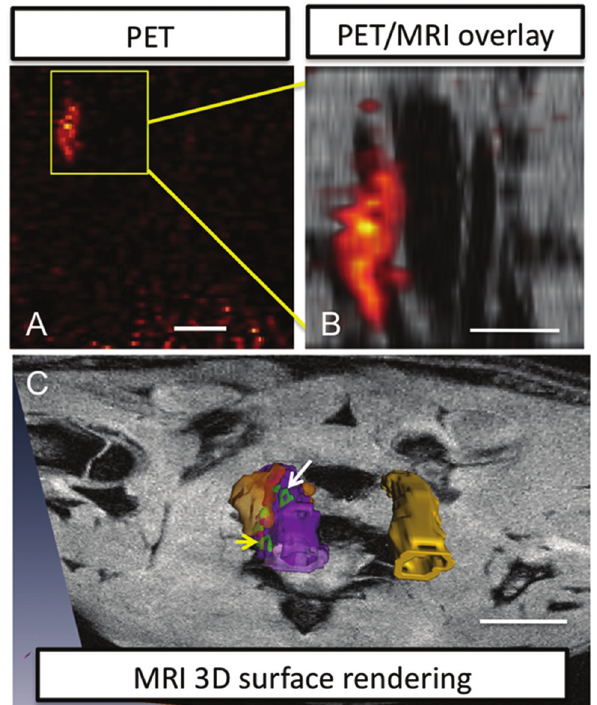
Figure 2. Multimodal macromolecular probes accumulate in the injured vessel of the rat carotid clamp injury model. (A) Coronal view PET image of the rat thorax shows a region of high signal intensity indicating probe accumulation in macrophages, however it is difficult to interpret the tissue of origin for the signal without anatomical information. Scale bar =20 mm (B) ‘‘Zoomed in’’ MR images for the volume indicated by the boxed area in A reveal that the PET signal correlates to the carotid artery on the left. Scale bar =5 mm. This vessel also shows elevated MR contrast and thicker vessel walls compared to the vessel on the right, (C) 3D reconstruction of MRI and PET data from the carotids is shown protruding from a plane in the MR image. This view illustrates that the probes are localized to the vessel wall of the injured carotid artery (purple), MR signal intensities elevated relative to vessel background signal are rendered in green, and PET intensities are in orange. The contralateral uninjured vessel is yellow. Images rendered by segmentation. MRI high contrast region, in green donut shape, at white arrow is 0.6 6 1.8 mm (volume is 0.4 6 2.6 6 0.6 mm 3 ; volume includes regions out of view in this 2D image). MRI high contrast signal at yellow arrow, in green horseshoe shape, is 0.8 6 1.2 mm, each arm is , 0.2 mm wide (volume